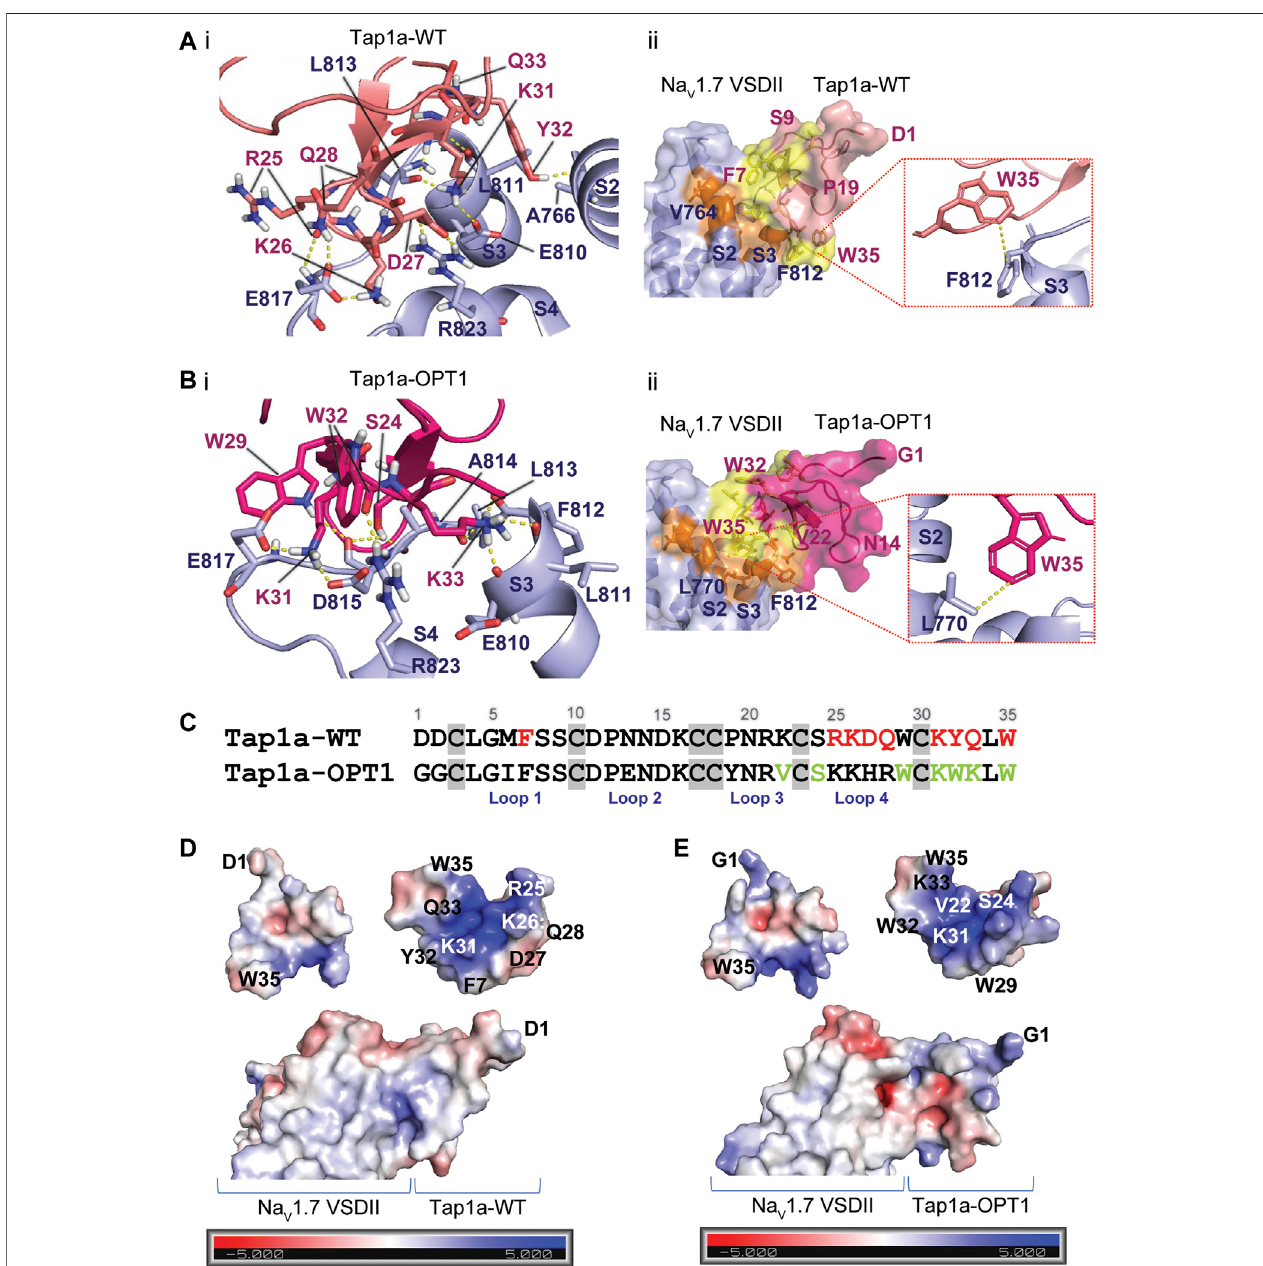
FIGURE6| Molecular modeloftheTap1aandTap1a-OPT1dockedonthehumanNa V 1.7channelDII. (Ai) Thethree-dimensionalrepresentation oftheinteractive surface of Tap1a-WT (salmon) docked over the hNa V 1.7 channel voltage sensor domain II / Na V Ab chimera (Na V 1.7 DII) (light blue) are represented in cartoon. Side chains are represented in sticks. Hydrogen bonds with distances up to 3Å are represented by dashed lines colored in yellow. (Aii) Hydrophobic interacting surfaces of Tap1a-WTcoloredinyellow andthehNa V 1.7DIIinorange. ZoominattheTap1a-WTC-terminalW35showingapotentialhydrophobicinteraction withF812inthe S3ofNa V 1.7DII.Distancebetweentheclosetcarbonsoftheiraromaticringsisrepresentedinyellowdashedlines.Sidechainsarerepresentedbysticks. (Bi) Thethree- dimensional representation of the interactive surface of Tap1a-OPT1 (pink) docked over the hNa V 1.7 DII (light blue) are represented in cartoon. Side chains are represented by sticks and hydrogen bonds with distances up to 3Å are represented by dashed lines colored in yellow. (Bii) Hydrophobic interacting surfaces of Tap1a- OPT1 colored in yellow and the hNa V 1.7 DII in orange. Zoom in at the Tap1a-OPT1 C-terminal W35 showing a potential hydrophobic interaction with L770 in the S2 of Na V 1.7DII.Distancebetweentheclosetcarbonsoftheirsidechainsisrepresentedinyellowdashedlines.Sidechainsarerepresentedbysticks. (C) Primarystructureof Tap1a-WT and Tap1a-OPT1 colored in red the residues predicted to form the strongest interactions between Tap1a-WT and hNa V 1.7 DII, and in green the residues predicted to form the strongest interactions between Tap1a-OPT1 and hNa V 1.7 DII. (D, E) Electrostatic surface of Tap1a-WT (D) and Tap1a-OPT1 (E) . Their predicted interactive ionic surface is visualized in the top right representations. The electrostatic potential of the interacting surfaces of Tap1a-WT or Tap1a-OPT1 with the Na V 1.7 DII are visualized in the bottom representation of each fi gure. Electron density charge bars range from – 5.0 (red) to +5.0 (blue).